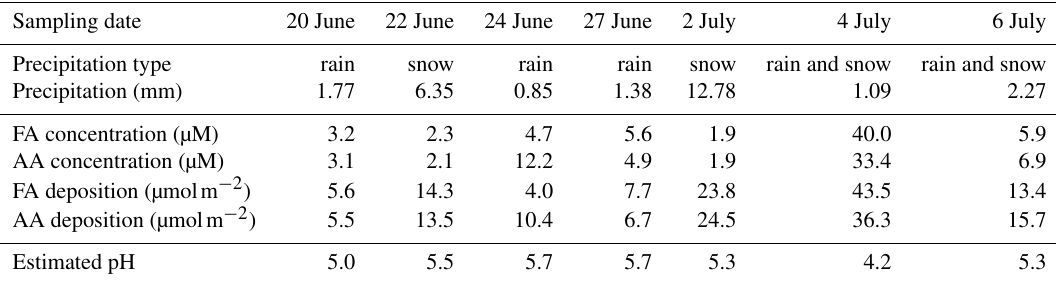
Figure 5. Time series FA (red) and AA (black). Gray bars indicate the duration of precipitation events as determined from all-sky camera images. Precipitation amounts (in mm) are shown where data are available. Table 2. Precipitation data for FA and